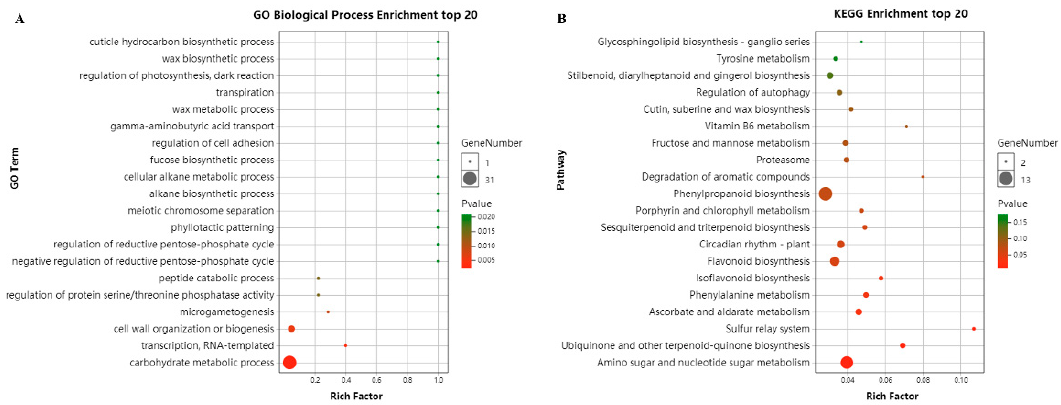
Figure 5. The top 20 GO terms ( A ) and KEGG pathways ( B ) for CsCBF target gene enrichment. The black circles indicate the number of target genes, and di ff erent colors indicate the level of p value, ranging from 0 to 1.